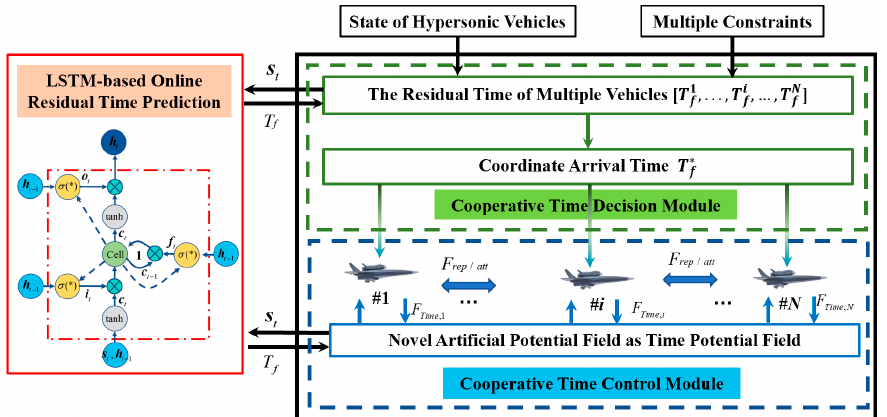
Figure 2. The framework of time cooperative guidance.